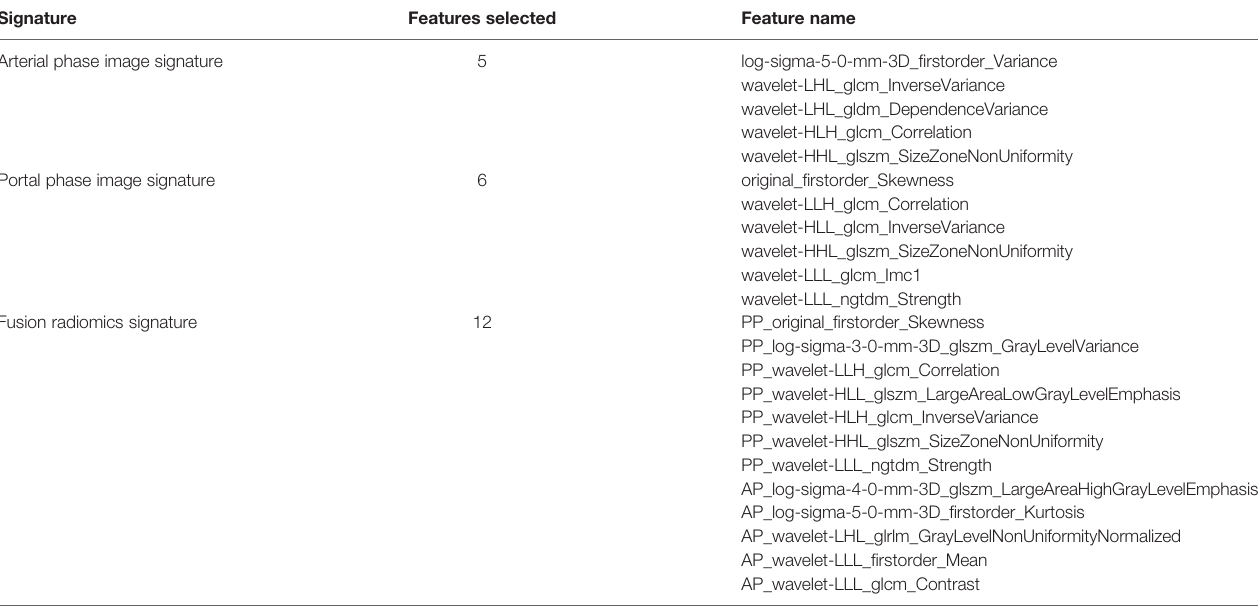
TABLE 2 | The list of selected features in three radiomics